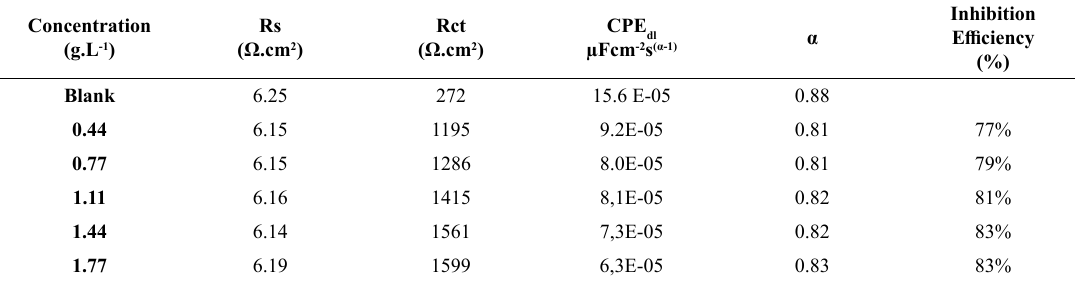
Table 3. Parameters from the fitting of EIS diagrams with the equivalent circuit of Figure 4 for corrosion of AISI 1020 carbon steel in 0.5 mol.L -1 HCl in the absence and presence of different amounts of castor bark powder. Concentration (g.L -1